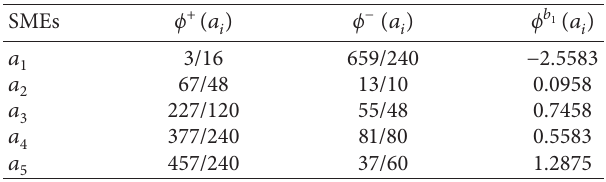
Table 4: The net of economic criteria. Table 5: Social criteria